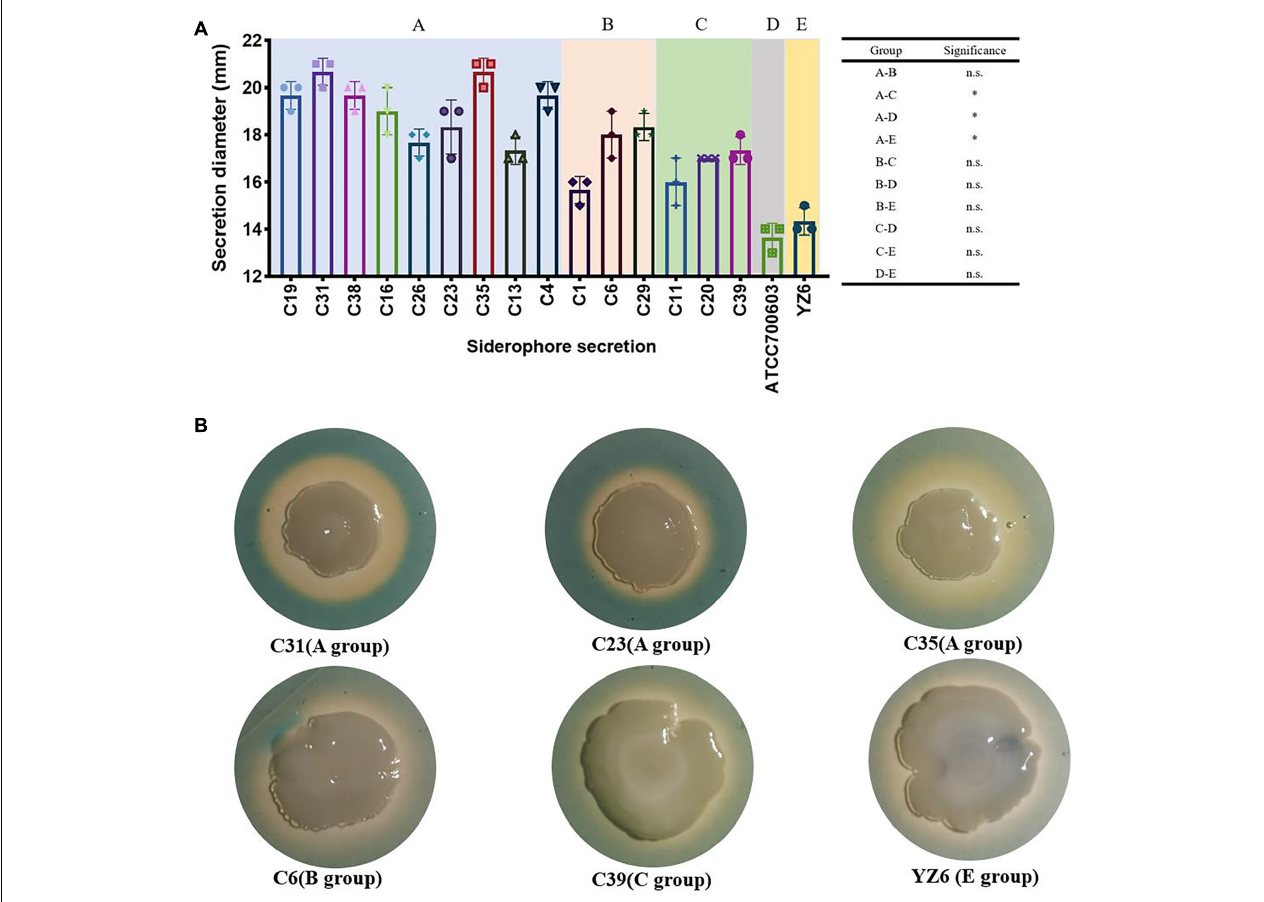
FIGURE 7 | Results of siderophore secretion experiments. (A) The siderophore secretion diameters (showed in millimeters) of CRKP and control isolates. n.s., not significant, ∗ p < 0.01. (B) The siderophore secretion zone of six representative isolates on CAS agar; the orange–yellow ring around the colonies indicates the siderophore